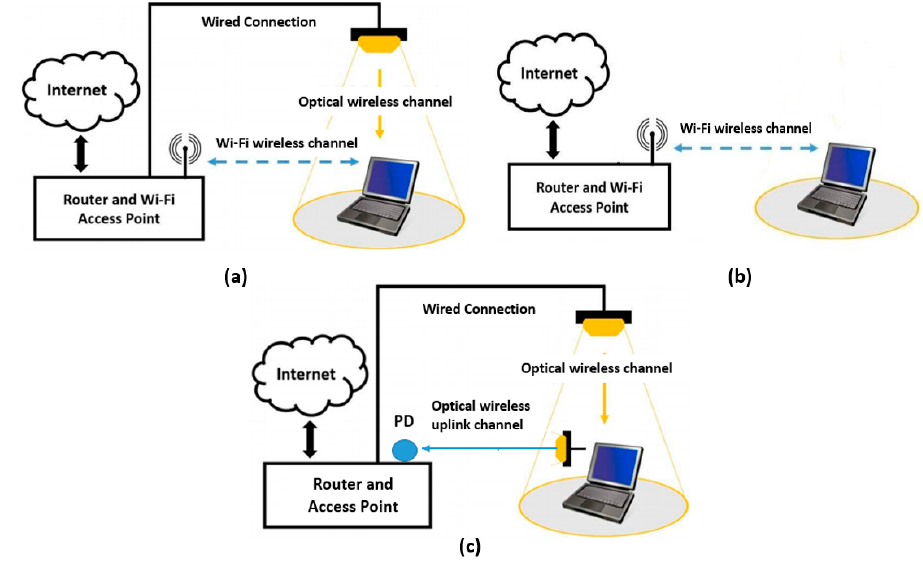
Figure 4. ( a ) Traditional Wi-Fi model; ( b ) hybrid VLC-Wi-Fi model; and ( c ) proposed full-duplex multi-user VLC system. PD: photodiode.